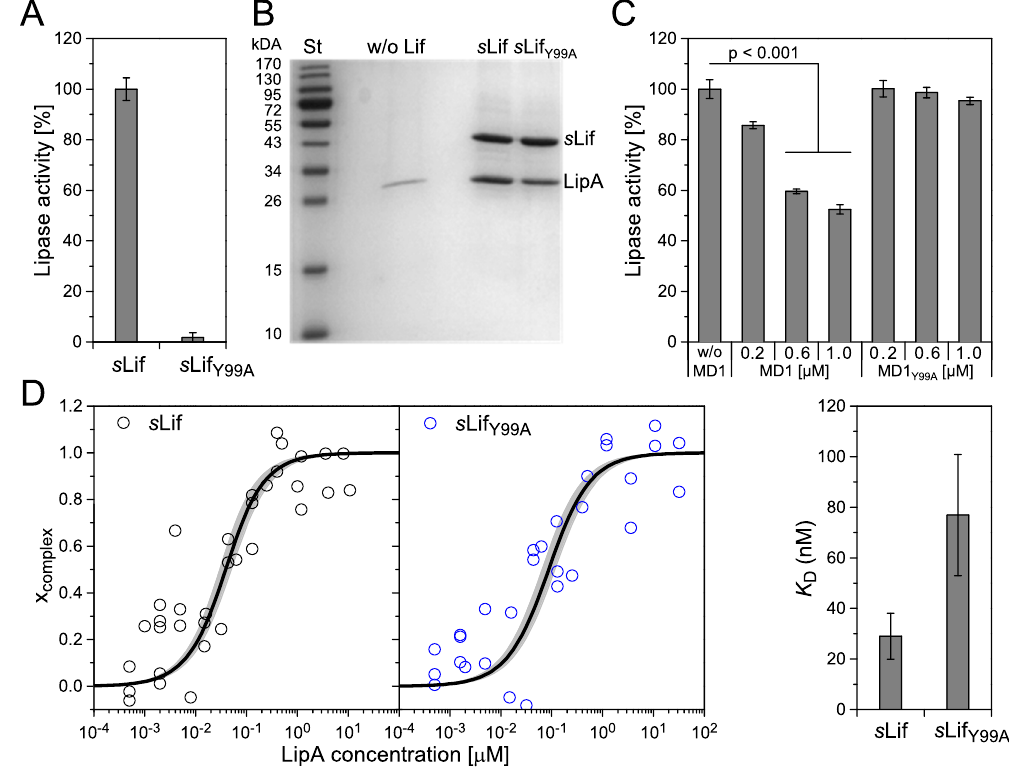
Figure 2. Activation of P. aeruginosa lipase LipA with s Lif and variant s Lif Y99A and effect of MD1. ( A ) Pre- active LipA (4 µ M) was incubated with either s Lif (4 µ M) or variant s Lif Y99A (4 µ M) followed by lipase activity assay with 10 nM LipA. The activity of s Lif:LipA complex was set as 100%. ( B ) SDS-PAGE analysis of LipA co-purified in the complex with s Lif or s Lif Y99A as well as without Lif (w/o Lif). In the Coomassie Brilliant Blue G250 stained gel LipA is migrating as ~30 kDa and s Lif as 43 kDa protein. Molecular weights of standard proteins (St) are indicated on the left-hand side. ( C ) Inhibition of s Lif-mediated LipA activation with MD1. Pre-active LipA (50 nM) incubated with MD1 or MD1 Y99A was activated by addition of s Lif (50 nM) and 10 min incubation prior to lipase activity measurement. Lipase activities are mean values ± standard deviation of three independent experiments each measured with at least three samples. ( D ) A fluorescence assay was used to study the complex formation of pre-active LipA and s Lif/ s Lif Y99A labelled at amino groups with BDP FL. The fraction of fluorescence parameters assigned to the s Lif:LipA complex (steady-state anisotropy r steady-state (Eq. 2, Table S1) and average translational diffusion time ‹ t trans › (Eq. 3, Table S2). The binding data were fitted with a 1:1 binding affinity model (Eq. 4), black line. The uncertainties are indicated as shaded areas. Steady-state anisotropy could not be used for s Lif Y99A :LipA complex because increased mobility of the fluorescent probe cancels the increase of global rotation correlation time ρ global . The apparent dissociation constant K D (right panel) was determined to 29 nM ± 9 nM for s Lif:LipA and 77 nM ± 24 nM for s Lif Y99A :LipA complex (error bars are standard errors of the